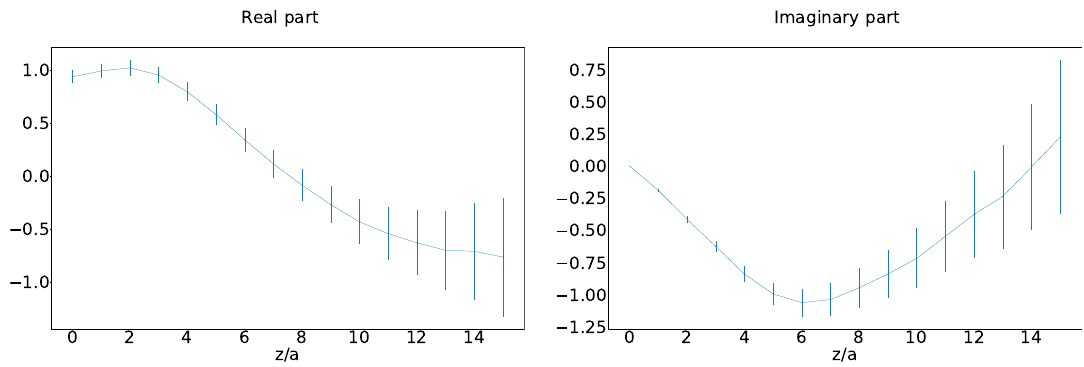
Figure 1 . Real (left) and imaginary (right) part of the quasi-PDF ME for the data used in this work, computed in refs. [30, 45]. The error band displayed accounts only for statistical uncertainty. The separation z is expressed in units of the lattice spacing a